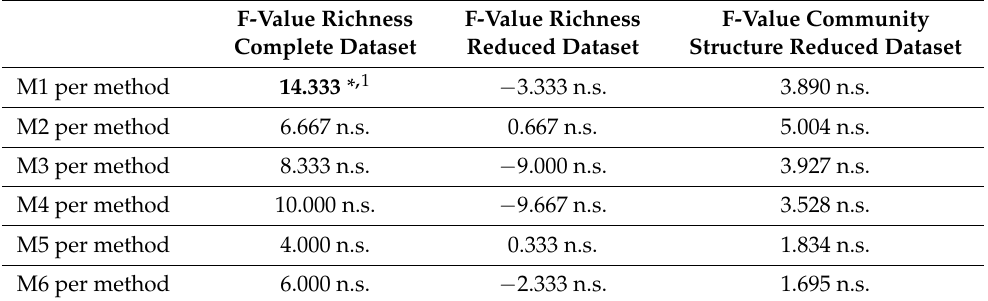
Table 2. Post-hoc Tukey HSD analysis to test the intra-site variation of species richness community structure according to method on the complete and the reduced dataset. In bold, significant